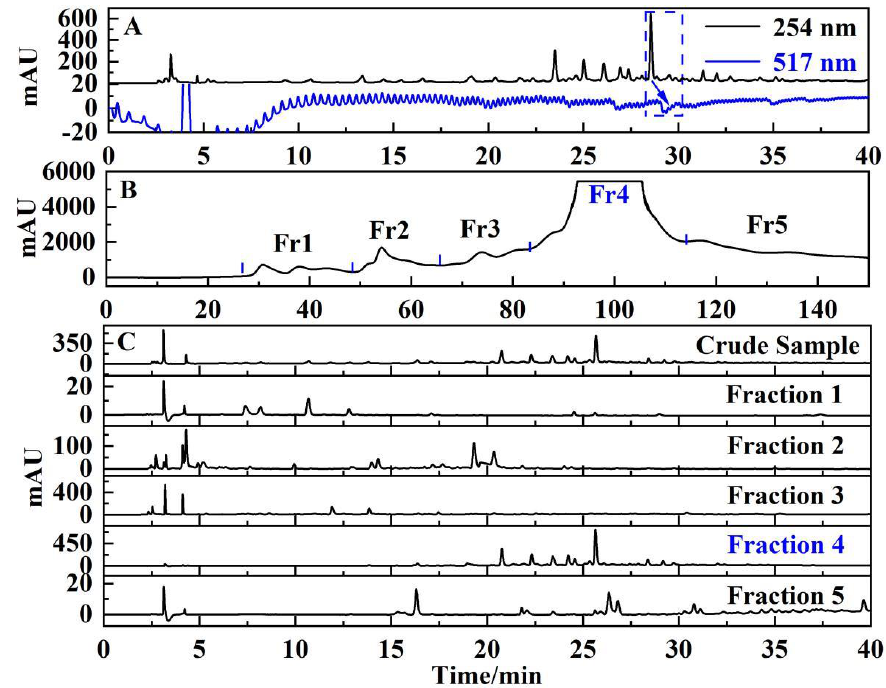
Figure 2. ( A ): The analytical spectra and 1,1-diphenyl-2-picrylhydrazyl (DPPH) inhibitory spectra on a Dubhe C18 analytical column of the L. latifolium crude sample. ( B ): the microgel ® chp20p medium pressure liquid separation chromatography of L. latifolium . ( C ): HPLC analysis of the L. latifolium crude sample and Fr1-Fr5 on the analytical column (Dubhe C18) with the same conditions as